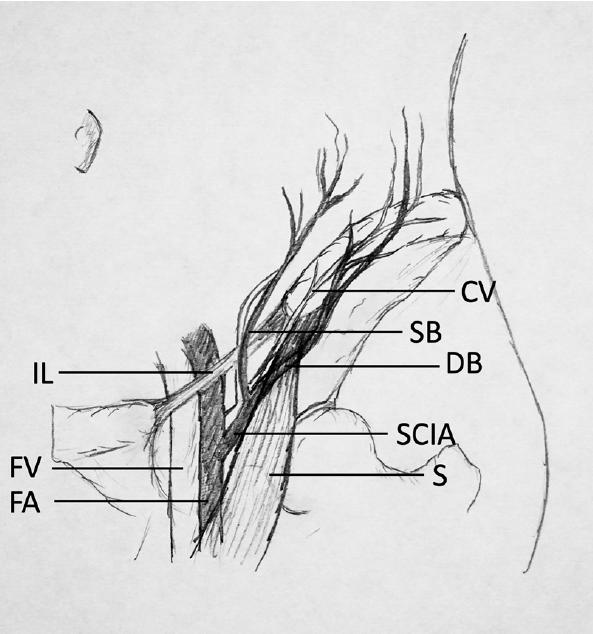
Figure 1. Simplified overview of the anatomy of the groin. IL = inguinal ligament; FV = femoral vein; FA = femoral artery; CV = cutaneous vein; SB = superficial medial branch of SCIA; DB = deep lateral branch of SCIA; SCIA = superficial circumflex iliac artery; S = sartorius.